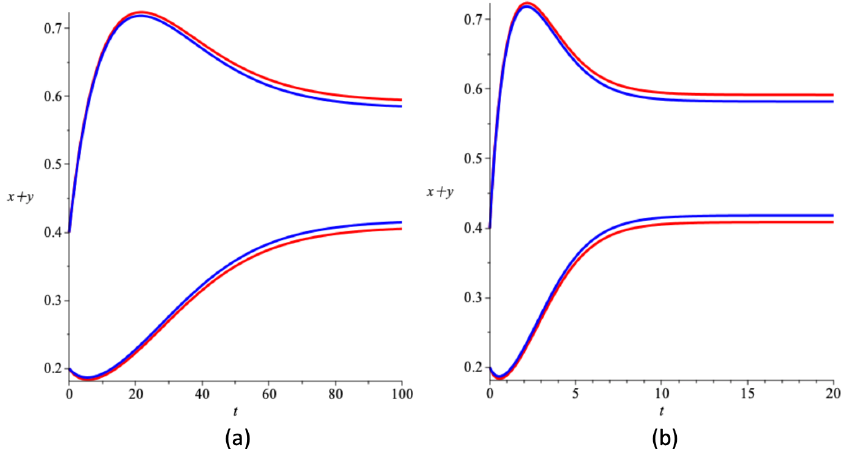
Figure 3. Comparison of complete (blue) and aggregated (red) solutions. ( a ) m 1 = 0.3, m 2 = 0.7 and (cid:101) = 0.1 ( b ) m 1 = 3, m 2 = 7 and (cid:101) = 1. Parameters set: s in = 0.5, u = 0.7, µ = 8.5 and k = 2.5. Initial conditions for complete model are s 1 ( 0 ) = s 2 ( 0 ) = 0.2, x 1 ( 0 ) = x 2 ( 0 ) = 0.1, and for aggregated model s ( 0 ) = 0.4, x ( 0 ) =